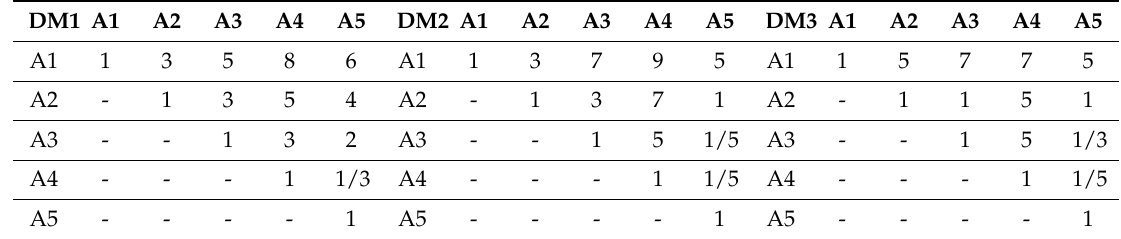
Table 1. Pairwise comparison matrices for the three decision